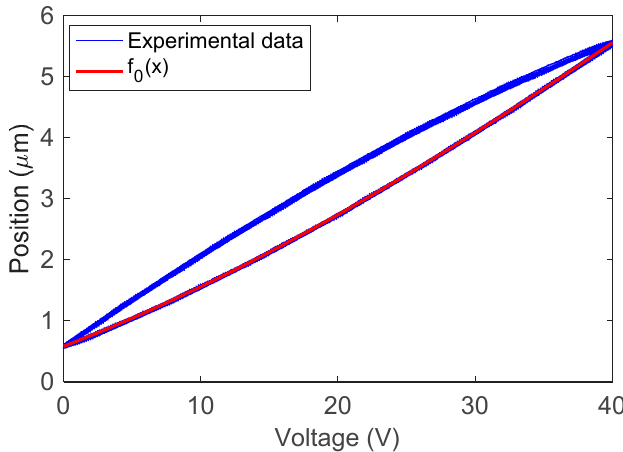
Figure 11. Input and output data used for parameter identification.